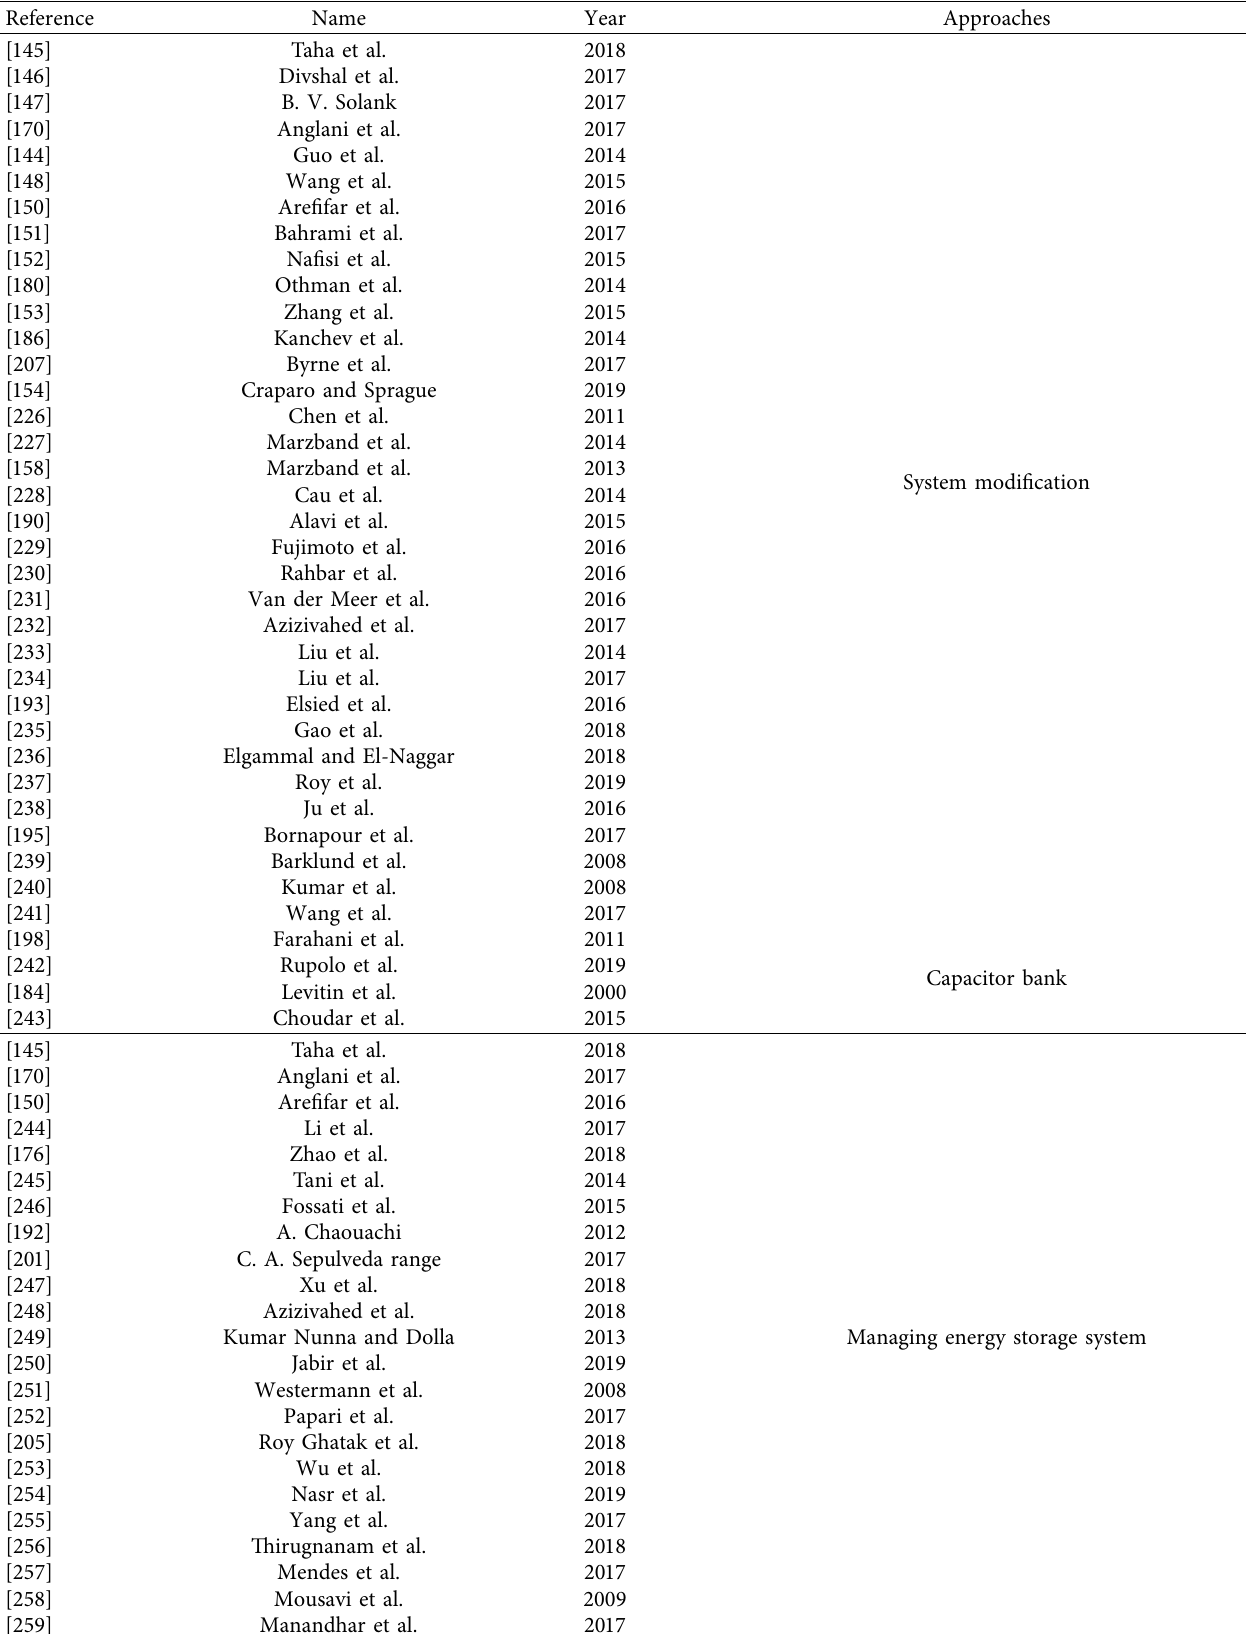
Table 8: Approaches to the energy management